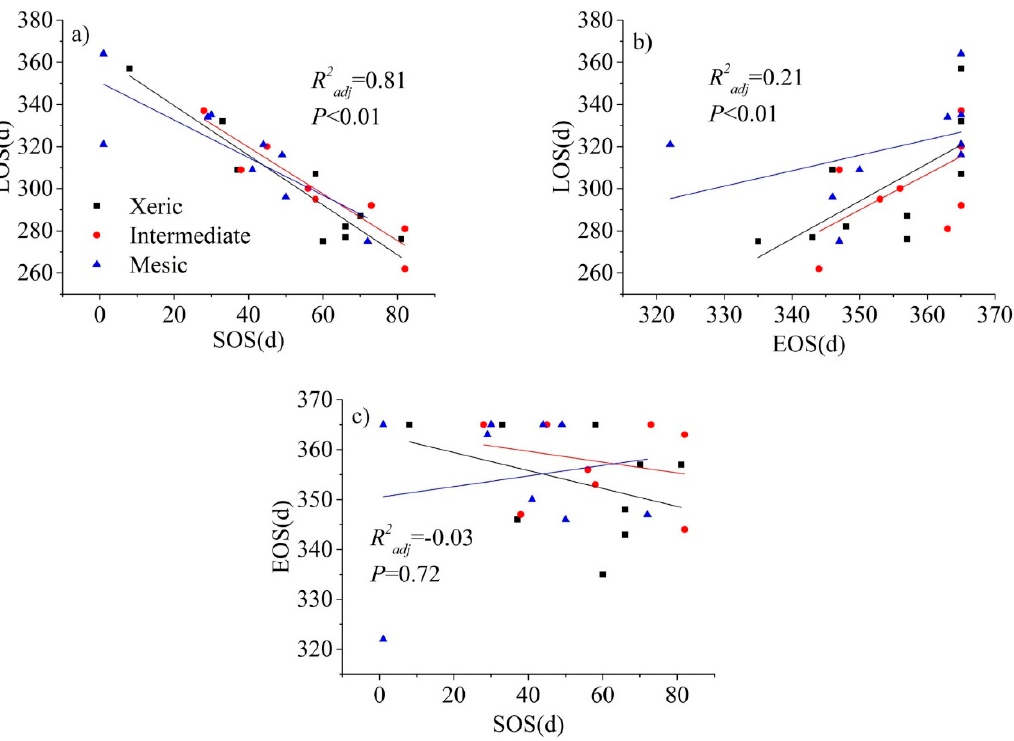
Figure 6. Relationship between ( a ) LOS and SOS, ( b ) LOS and EOS, and ( c ) EOS and SOS by site (N = 27). SOS = start of growing season, EOS = end of growing season, LOS = length of growing season.